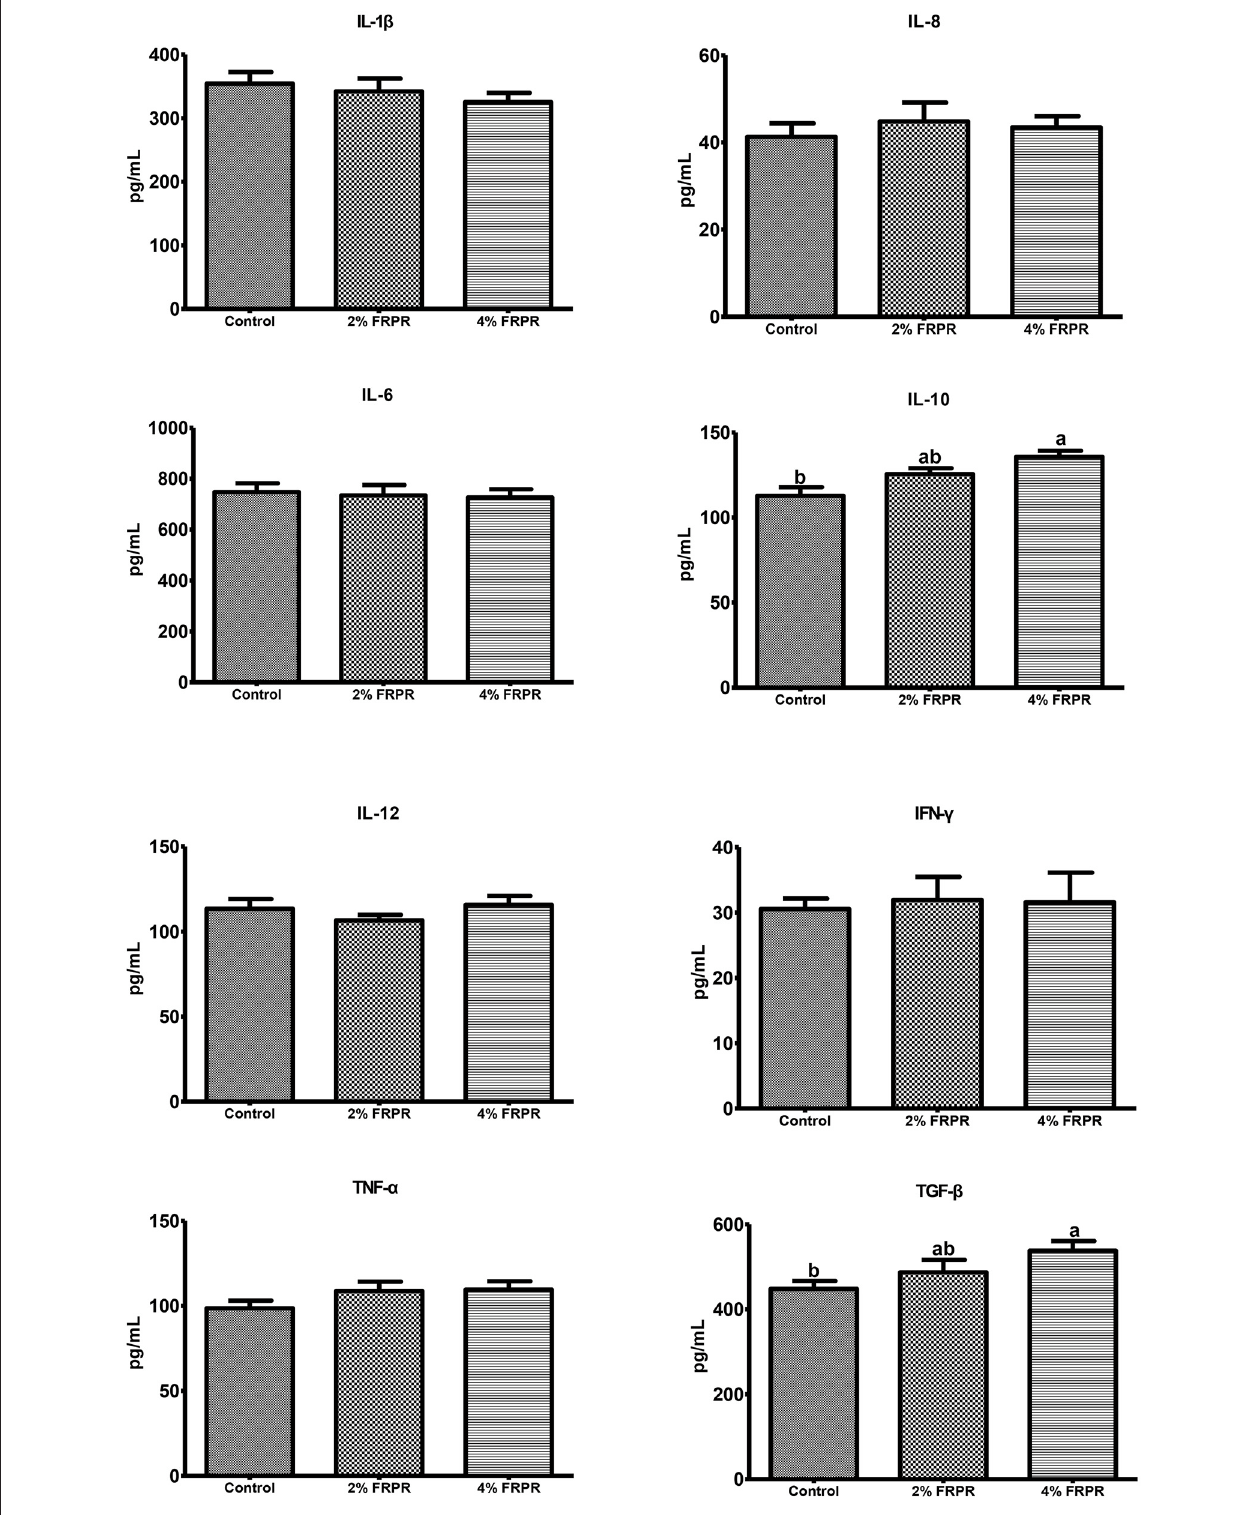
FIGURE 1 | Effect of maternal dietary supplementation with FRPR on serum concentrations of cytokines in offspring piglets. Values were means ± SEM, n = 12. a,b Values with different lowercase letters are different ( P < 0.05).